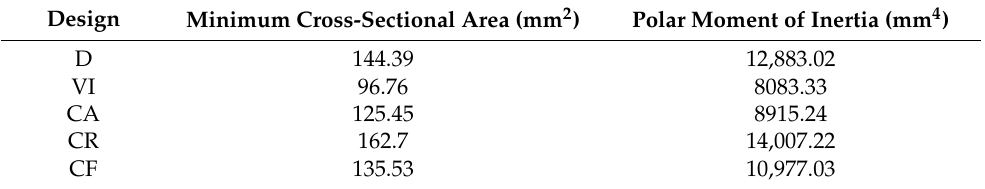
Table 4. Polar moment of inertia values based on the minimum cross-sectional area of